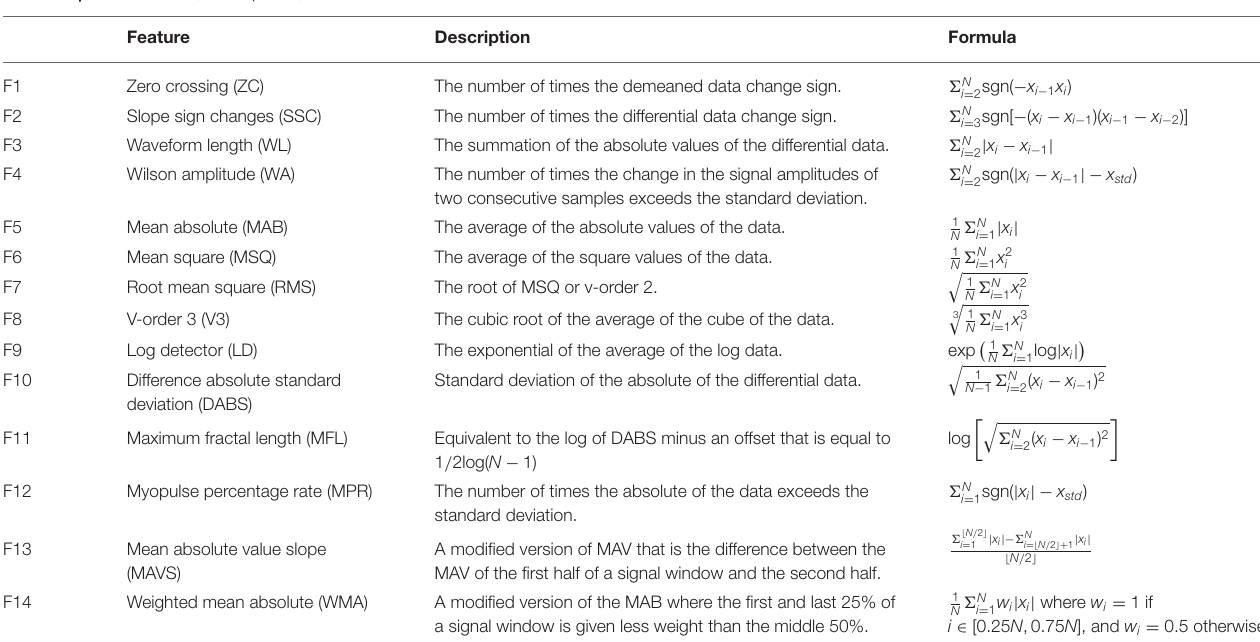
TABLE 1 | List of features, descriptions, and